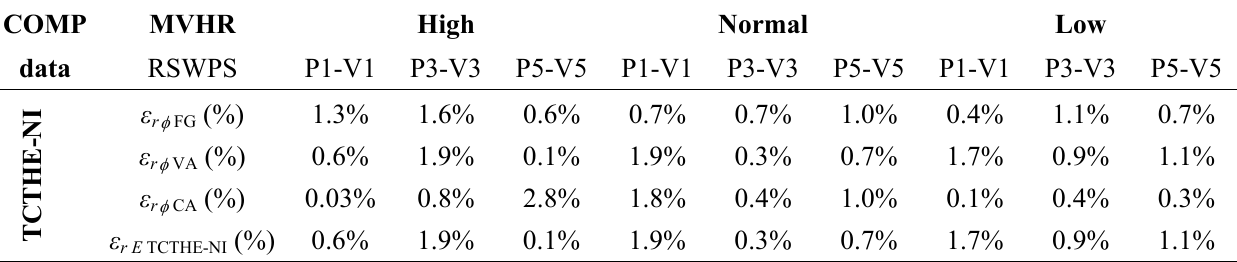
Table 8. Relative differences between experimental and computed results within the